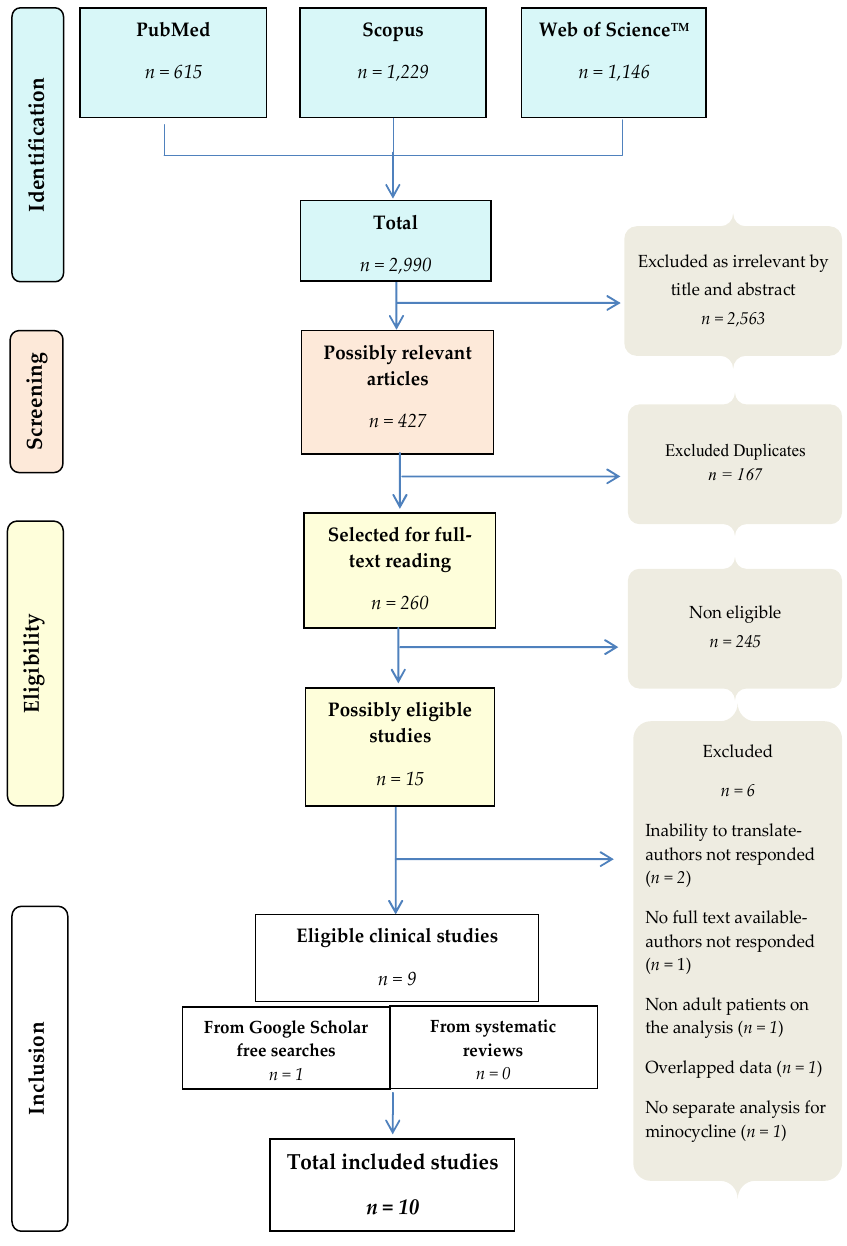
Figure 1. Systematic review flow chart. Table 2. Included Clinical Studies.